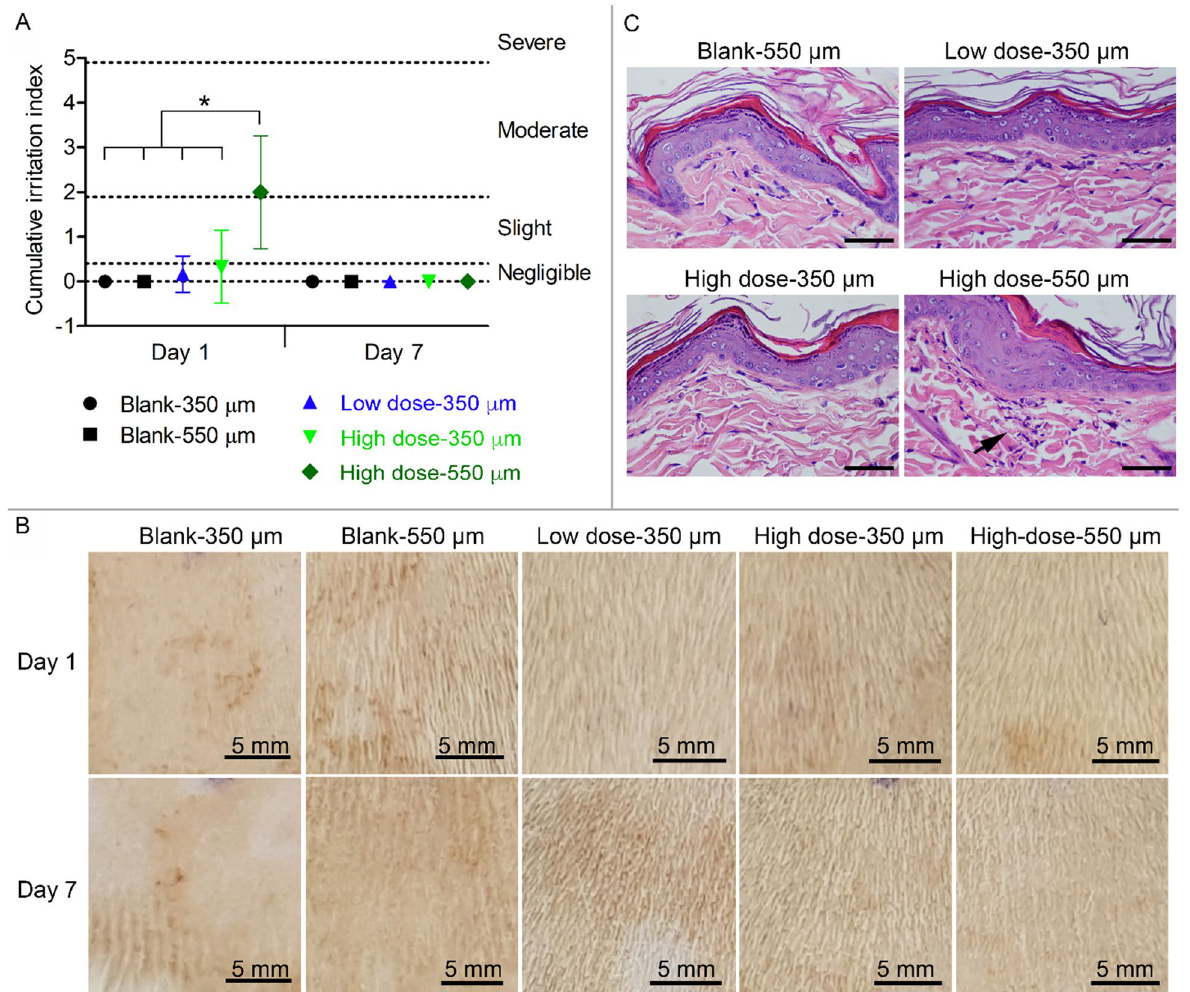
Figure 3. In vivo skin irritation. ( A ) Cumulative irritation indexes from the rat skin at day 1 and day 7 after single DDMN administration. Statistical analysis was carried out using one-way ANOVA followed by Tukey post hoc test at the significant level of p < 0.05, and *represents significant difference. Data are shown as mean with the error bars represent standard deviation obtained with n = 3 for unloaded DDMNs (Blank-350 µm and Blank-550 µm); and n = 6 for low dose-vitC-gluta-350-DDMNs (Low dose-350 µm), high dose-vitC-gluta-350- DDMNs (High dose-350 µm) and high dose-vitC-gluta-550-DDMNs (high dose-550 µm). ( B ) Macroscopic images of the rat back skin at the treated sites at day 1 (Top row) and day 7 (Bottom row) after single DDMN administration. ( C ) Representative histopathological images of the cross-sectioned skin tissues at the treated site of the rats, collected 1 day after the single DDMN administration. Black arrow points at the infiltrated mononuclear cells. Scale bar represents 50